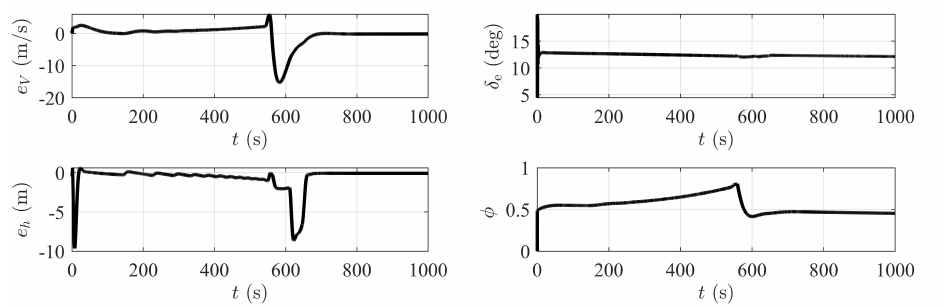
Figure 6. Response of trajectory